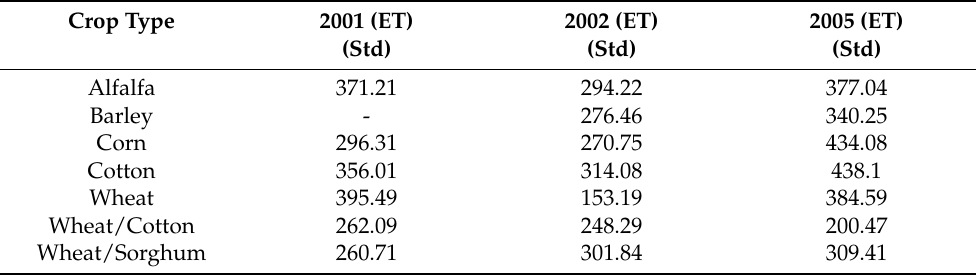
Table 11. Variation of water consumption (Std) by crop